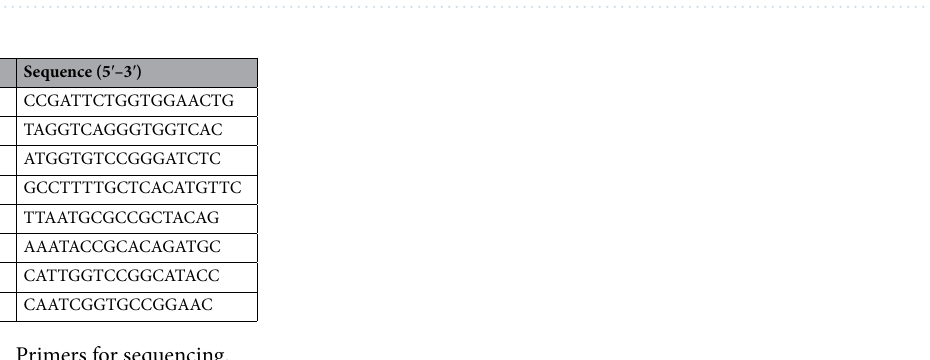
Table 3. Primers for sequencing.